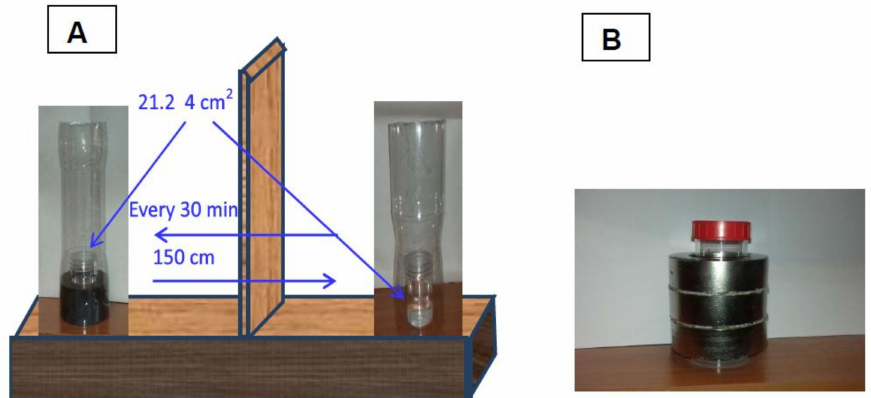
Figure 2. ( A ) Evaporation experiment: the MF-treated (left) and untreated (right) samples. ( B ) MF treatment for surface tension